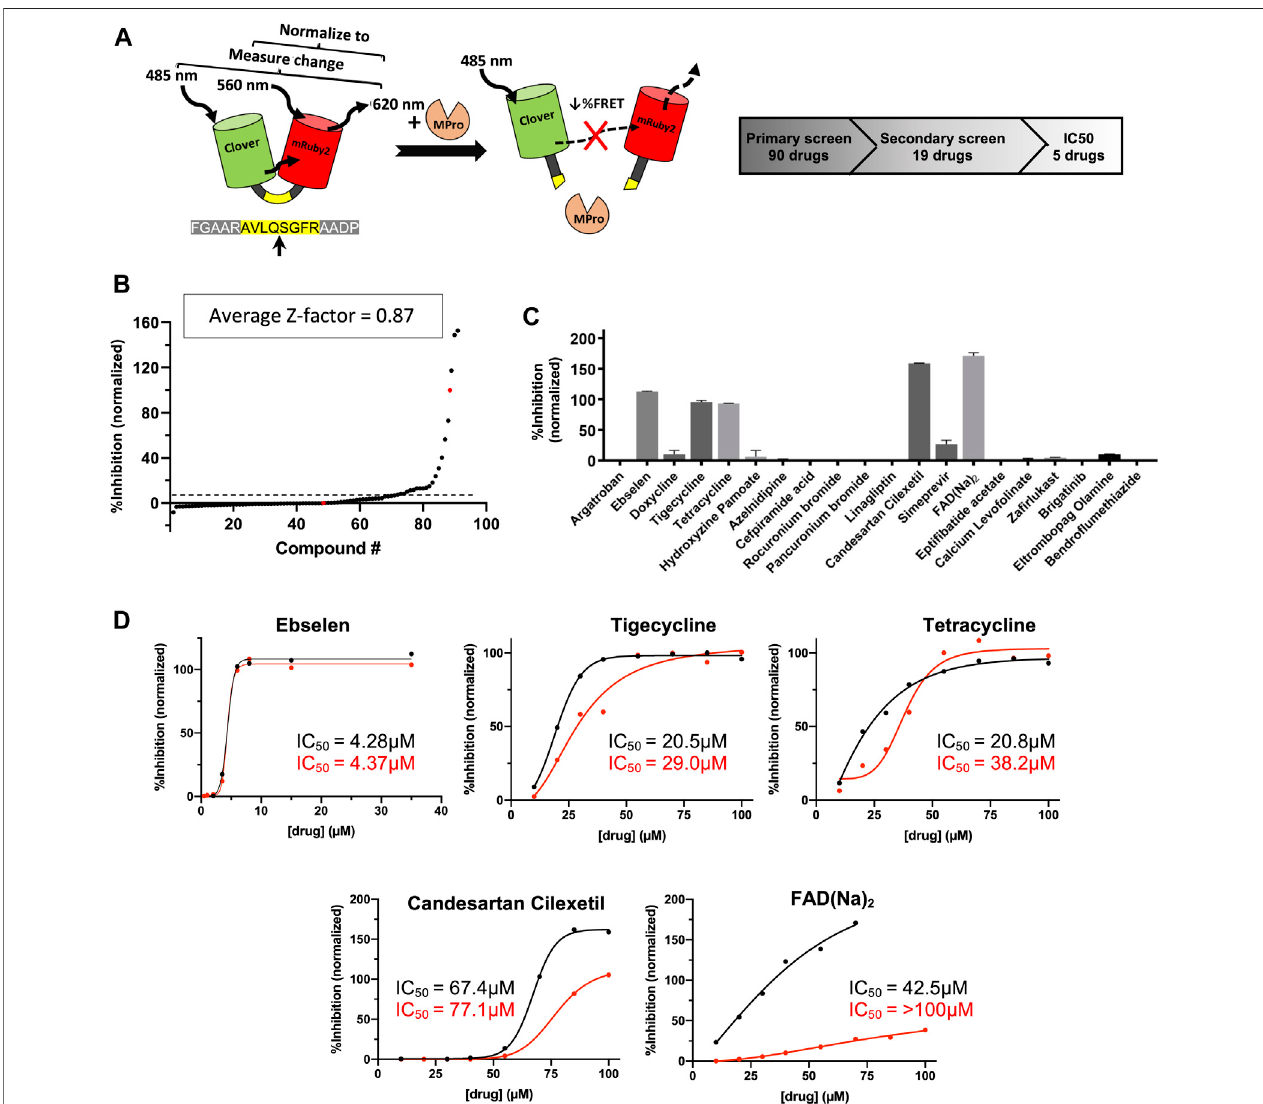
FIGURE 2 | Predicted M pro drug inhibitors screened using a FRET-based protease assay with fi ve down-selected hits. (A) A schematic of the FRET-based SARS- CoV-2 main protease assay is shown along with the hit identi fi cation overview. (B) Puri fi ed M pro and FRET substrate proteins were incubated in the presence of 100 μ M ofdrugsfrom alibrary ofcomputationallypredictedM pro inhibitors.Nodrug, no protease, and Ebselenwereused ascontrolsto calculate the Z-factor for each plate and an average score is displayed above. Red dots indicated no drug (0% inhibition) or no protease (100% inhibition) conditions, while the black dots are the ordered percentinhibition values. (C) Identi fi edhitsfrom theprimaryscreenwerere-screened at100 μ Mand theFRET valueswere normalized aspercent inhibition values inthe bar graph. Experiments were performed induplicate and the presented resultsare theaverage values. (D) Veri fi ed compounds form rescreeningweresubjectedtohalf- maximal inhibitory concentration (IC 50 ) analysis. Presented values are averaged from technical duplicate experiments. Black lines and values represent normalized data from FRET values while the red lines and values represent normalized data from gel electrophoresis ( Supplementary Figure S1 ) and